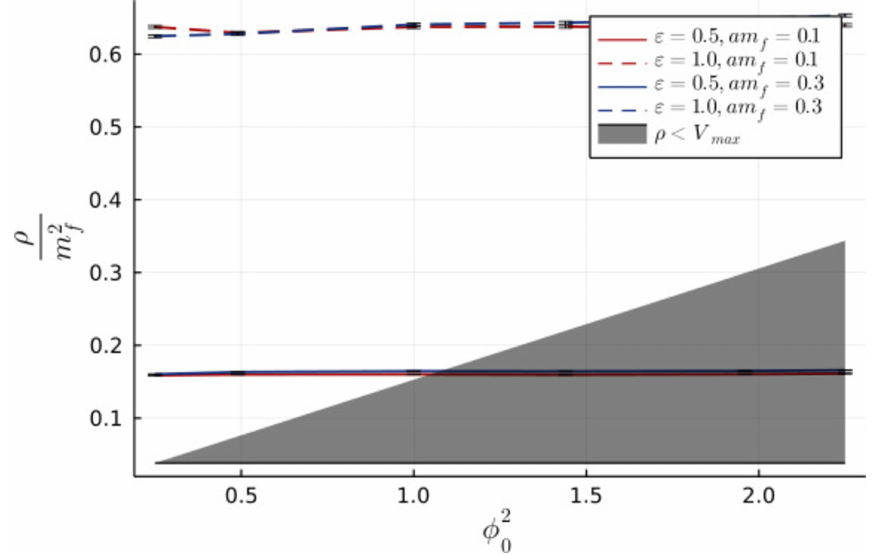
Figure 8 . The dependence of energy density on φ 0 and (cid:15) . We also see a small dependence on the cut-off am f